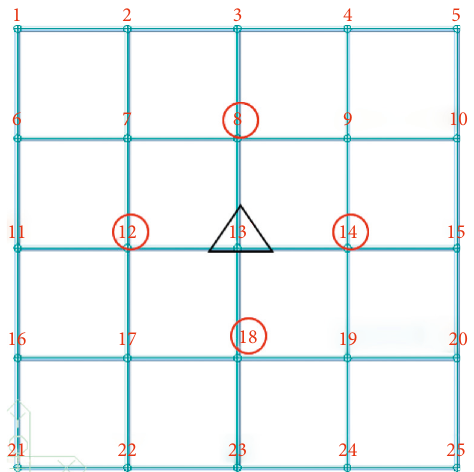
Figure 6: Schematic diagram of vertical poles’ numbers.